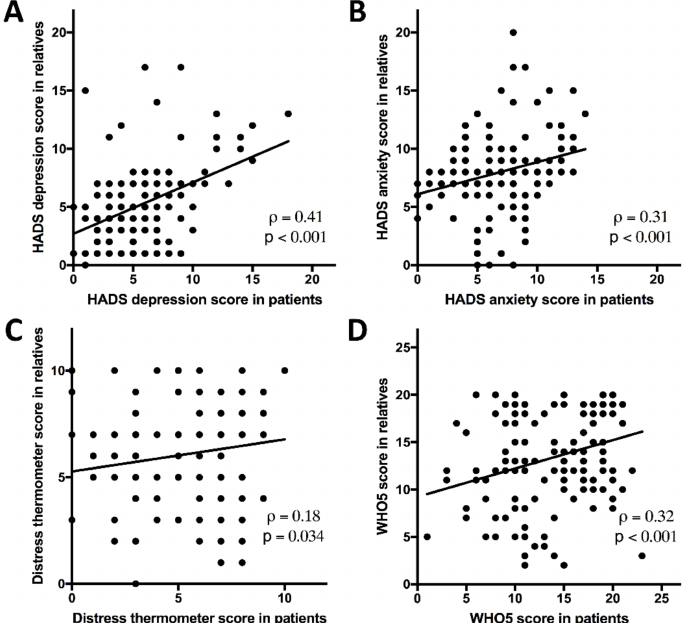
Figure 2. Patient scores and those obtained from their immediate relative in the same week are plotted on the x and y axis, respectively. All four outcomes, depression ( A ) and anxiety ( B ) as measured by the Hospital Anxiety and Depression Scale (HADS) score, distress thermometer ( C ), and WHO5 well-being score ( D ) demonstrate significant correlations between patient and relative- reported outcomes from the same family at the same timepoint. Spearman’s ρ and corresponding p value are given for each